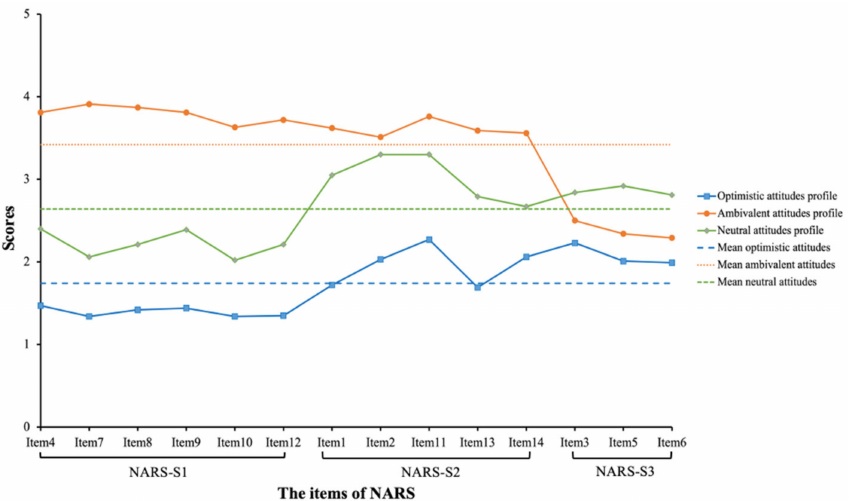
Figure 1. Latent profiles for the three-profile